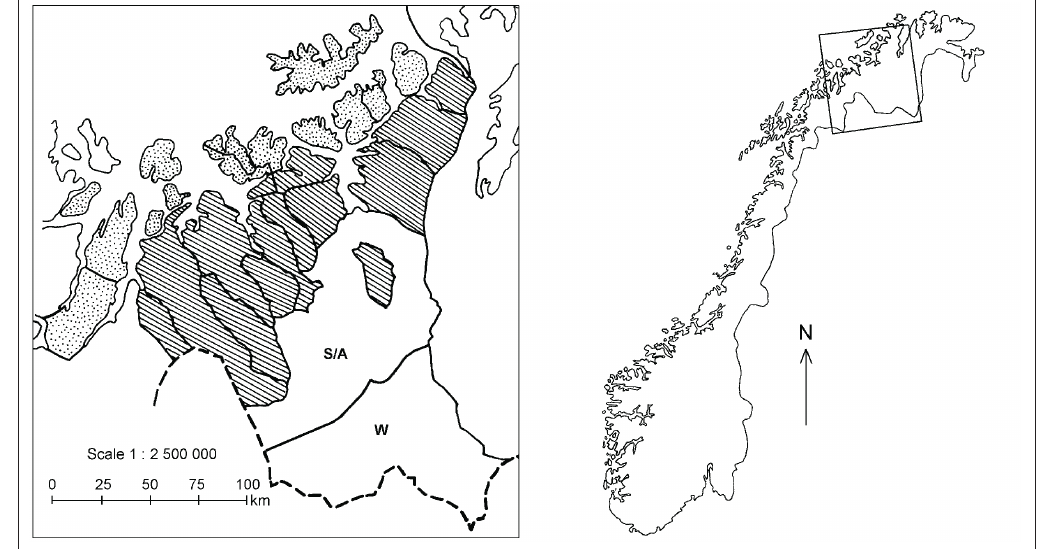
Fig. 1. Seasonal distribution of the ranges in West Finnmark, displaying the different summer herding dis- tricts (black signatures) and spring/autumn (S/A) and winter (W) (white areas) ranges further south. The summer herding districts are further divided into mainland districts (stippled) and island districts